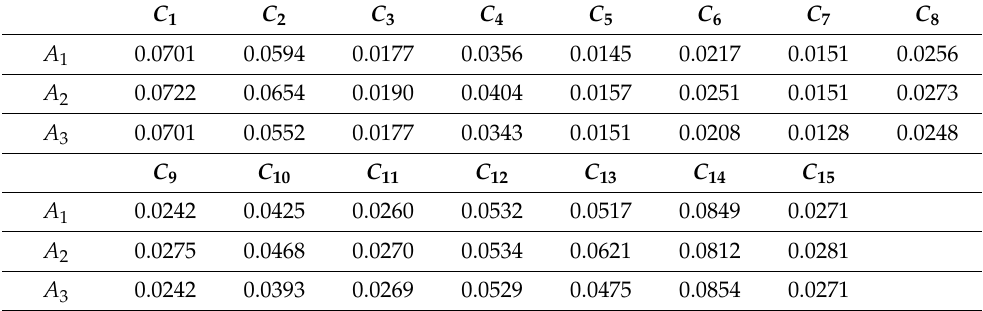
Table 6. Weighted evaluation matrix table.